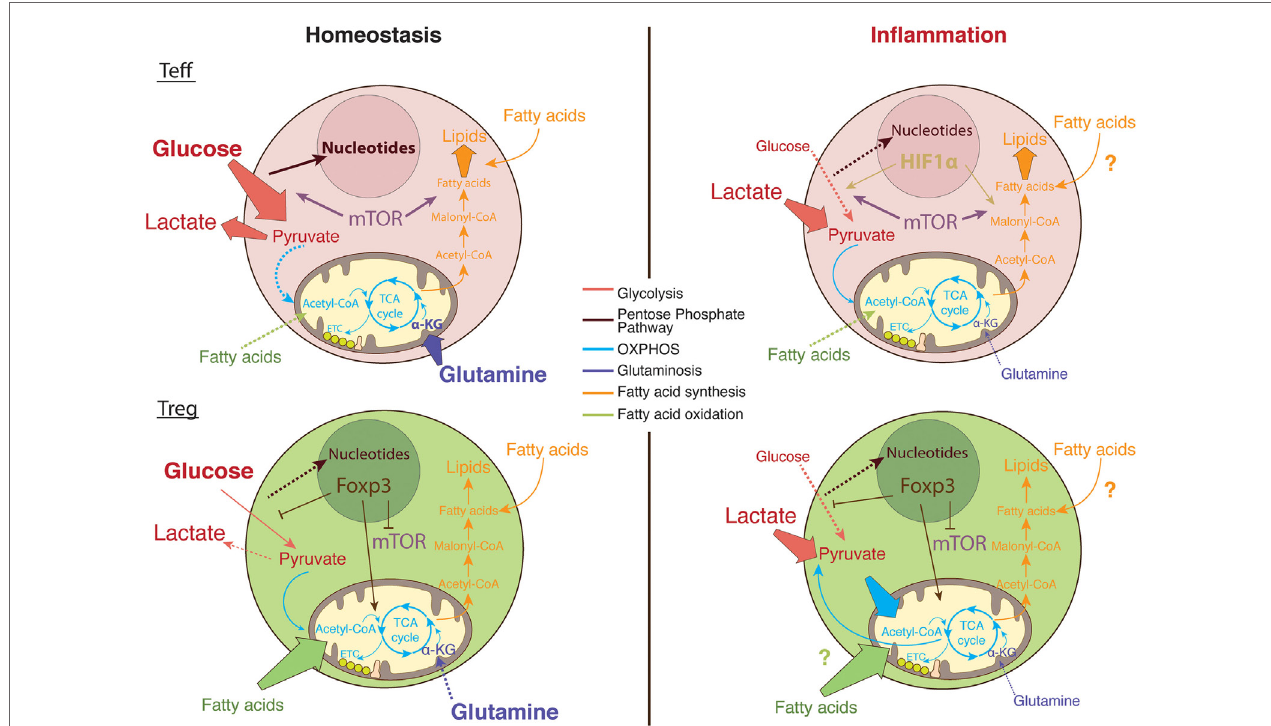
FiguRe 3 | The metabolic pathways utilized by T cells in nutrient replete versus metabolically challenging environments. Under homeostatic conditions, glucose enters the cytosol of activated T cells and is converted into pyruvate via glycolysis (89). Pyruvate can either be further metabolized into lactate and secreted or entered into the tricarboxylic acid (TCA) cycle to generate ATP via the electron transport chain (ETC) in the process of oxidative phosphorylation (OXPHOS) (120). Moreover, the glucose breakdown intermediates produced during glycolysis can be metabolized via the pentose phosphate pathway donating important building blocks for nucleotide and amino acid synthesis (89). Activated Teff cells rapidly augment fatty acid synthesis while concomitantly decreasing fatty acid oxidation (FAO). In comparison, regulatory T (Treg) cells actively take up exogenous fatty acids to sustain their proliferation through FAO (111). In addition, Teff cells rely on glycolysis and glutaminolysis to proliferate and obtain the necessary cofactors for survival while Tregs differentiation is enhanced in glutamine-deprived environments (3, 101). Foxp3 plays a major role in regulating the metabolic pathways necessary for Treg cells function by upregulating OXPHOS activity (149, 150), blocking mechanistic target of rapamycin (mTOR) signaling (156), and glycolysis (149). In the inflamed tissue, in low oxygen conditions, Teff cells upregulate survival mechanisms including the oxygen-sensitive transcription factor, hypoxia-inducible factor (HIF)-1 α . HIF-1 α promotes anaerobic metabolism through increased expression of glucose transporters, as well as induction of glycolytic enzymes (4, 45). However, glucose supply is limited in the inflamed tissue while lactate is abundant; therefore, T cells favor the conversation of lactate to pyruvate. Tregs are able to sustain the use of lactate-derived pyruvate as a source of energy through the generation of NAD + during OXPHOS